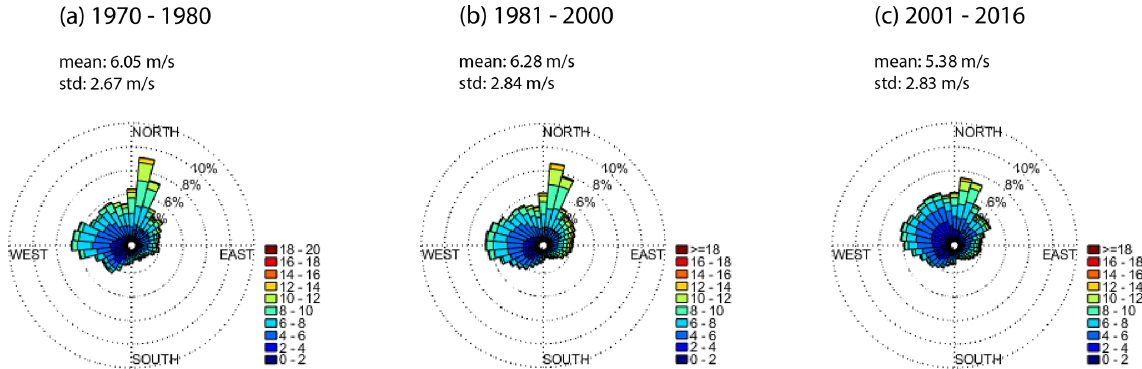
Figure 3. Rose plot of wind condition in years of (a) 1970–1980, obtained from the Halls Head weather station; (b) 1981–2000, obtained from the WRF weather model; and (c) 2001–2016, obtained from the Mandurah weather station.